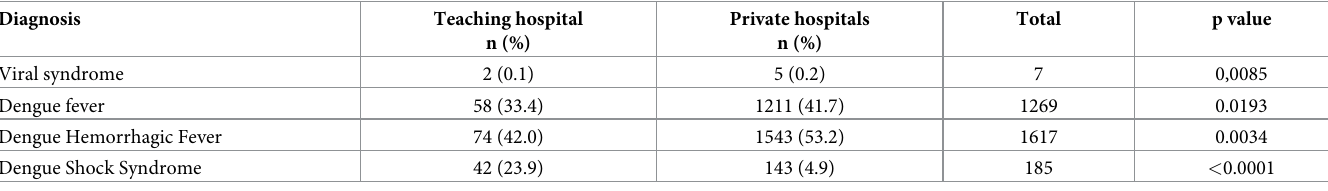
Table 1. Distribution of DVI patients based on hospital type.